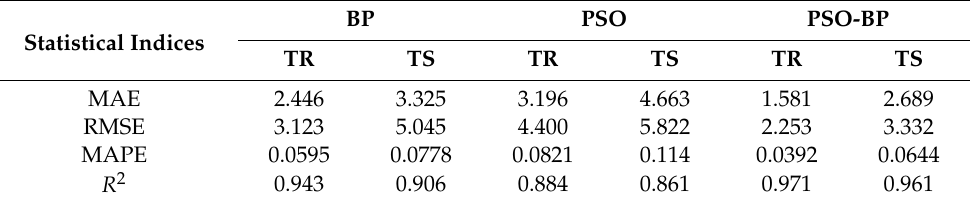
Table 4. Obtained statistical performance values for the developed models.